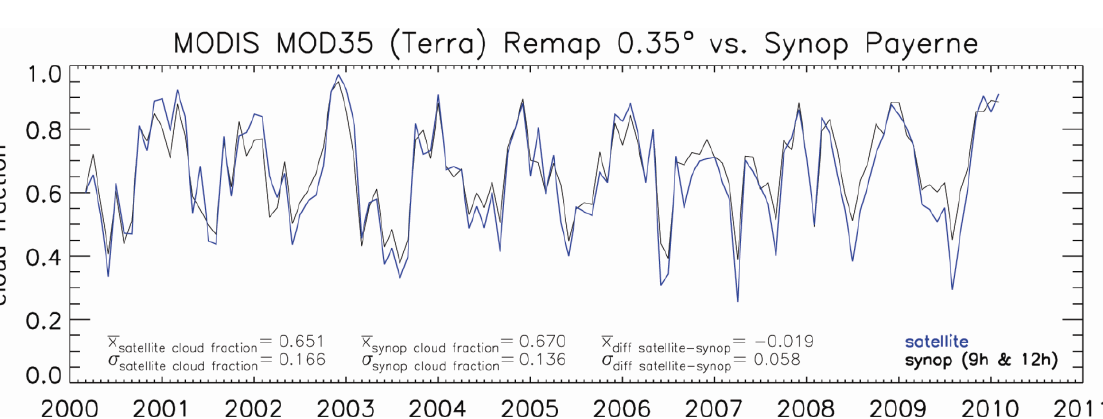
Figure 3. Comparison of MODIS Terra (based on MOD35 data, averaged at 0.35° grid) daytime monthly mean cloud fraction product with ground-based synop observations at Payerne (6°56′E, 46°48′N). The monthly Synop Payerne time series are based on synoptic observations made every three hours by a local observer (average of 9 h and 12 h